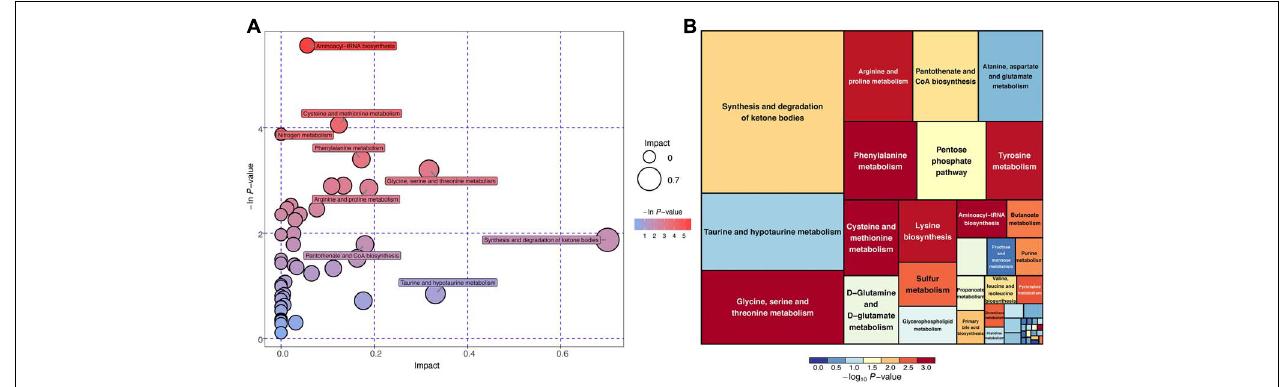
FIGURE 6 | KEGG pathway enrichment analysis for differential metabolites (POS mode). (A) Horizontal axis and size of bubble showed topological impact of pathways. Vertical axis and color of bubble showed p -value of pathways. (B) Size of square showed topological impact of pathways, whereas color of square showed p -value of pathways.